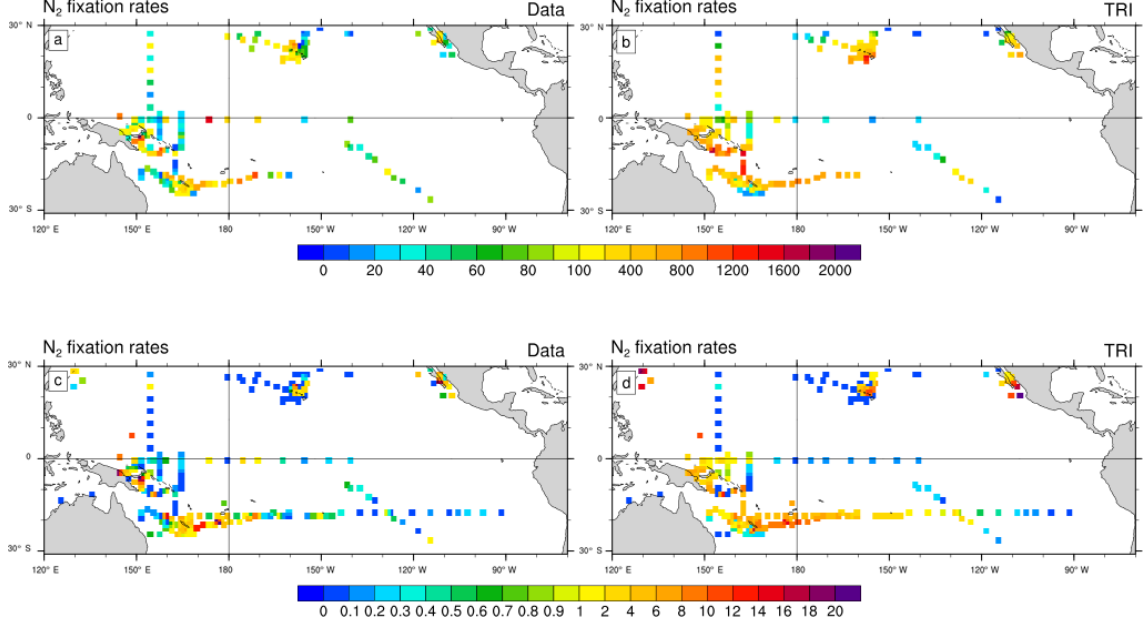
Figure 4. N 2 fixation rates (µmolNm − 2 d − 1 ) as observed (a, c) and as simulated by TRI simulation (b, d) . In panels (a) and (b) , N 2 fixation rates have been integrated over the top 150m of the ocean. In panels (c) and (d) , the vertical integration has been restricted to the top 30m of the ocean. Model values have been sampled at the same location, the same month (climatological month vs. real month), and the same depth as the